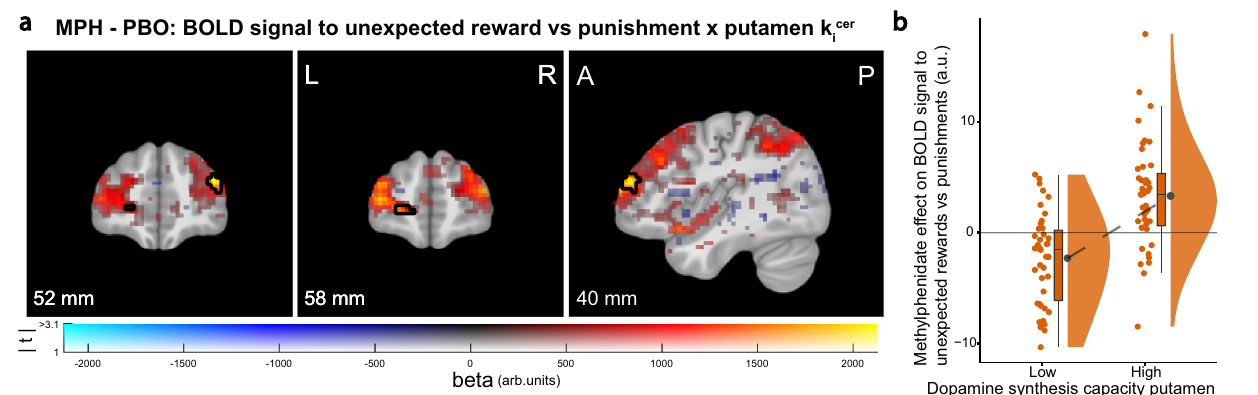
z = − 20, 59, − 2, Z =5.25, p clusterFWEWB =0.006).Figureconventionsare asinFig.1b. b Average contrast estimates extracted from the signi fi cant clusters in panel a displayed as a function of low and high putamen k i cer (median split for visuali- zation). Boxplots and round dots next to distribution kernels are de fi ned as in Fig.1c. N =85participantsinbothpanels.Sourcedataareprovidedwiththispaper. MPH methylphenidate, arb. units arbitrary units, k i cer dopamine synthesis capacity